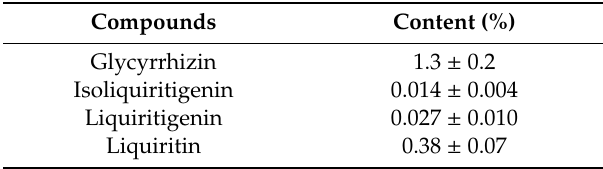
Table 6. The mean contents of four compounds in